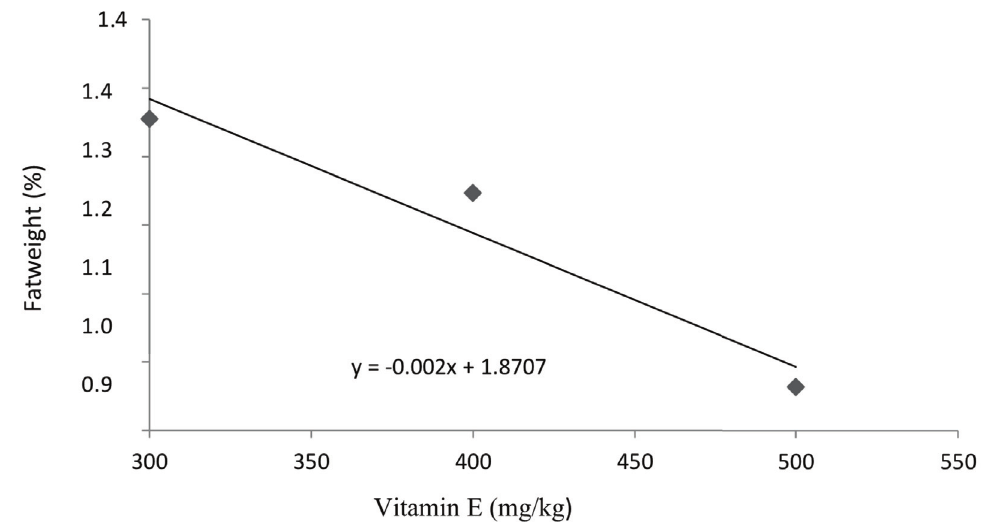
Figure 1 - Eff ect of vitamin E on the relative weight of abdominal fat of broilers at 42 days of age. Relative weight of organs of broilers at 42 days old fed diff erent levels of selenium and vitamin E. Vitamin Selenium